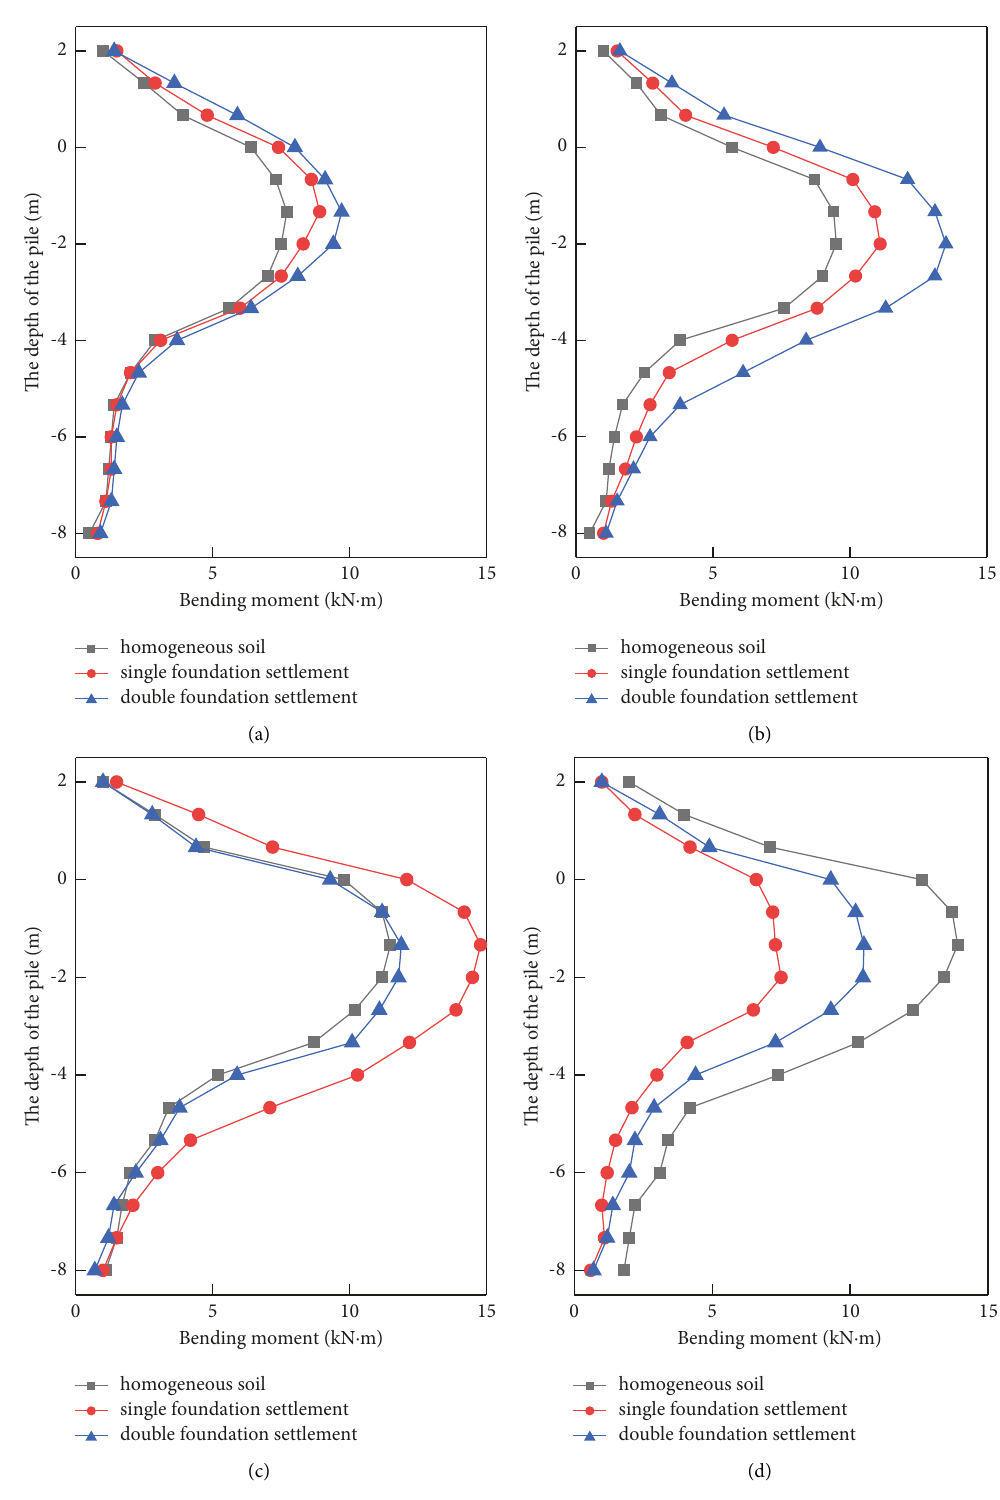
Figure 16: Bending moment diagram of inclined pile: (a) No. 1 pile cap, (b) No. 2 pile cap; (c) No. 3 pile cap; (d) No. 4 pile